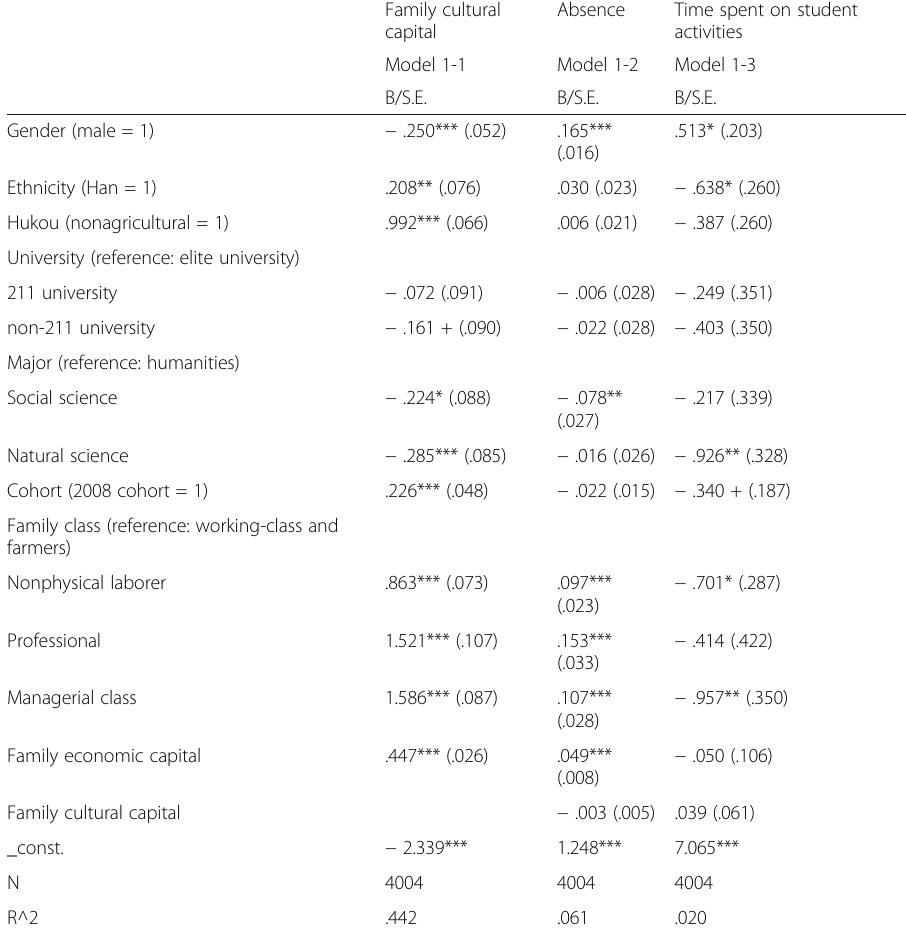
Table 3 Relationships among family class background, cultural capital, and individual effort Family cultural capital